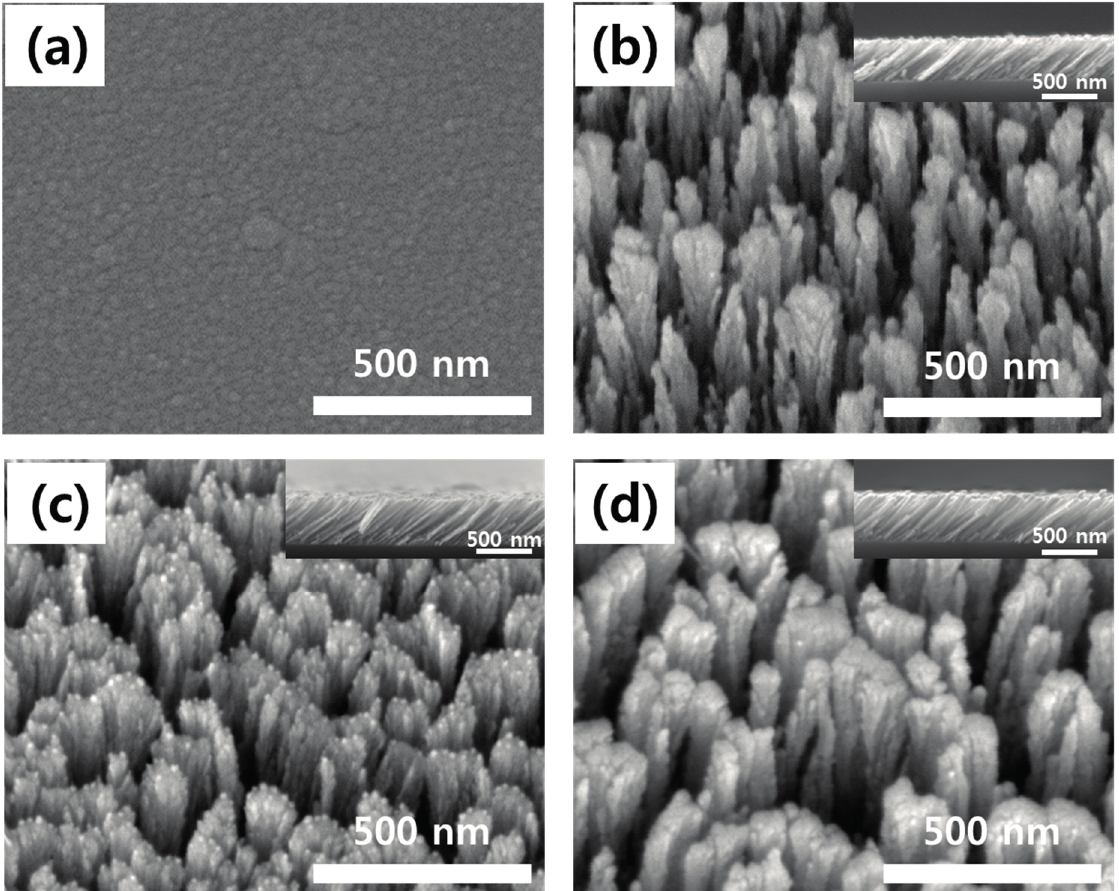
Figure 3. FESEM images. ( a ) Surface of SnO 2 thin film (glancing angle = 0°); ( b ) Surface and cross-section of SnO 2 thin film (glancing angle = 85°); ( c ) Surface and cross-section of Au-catalyzed SnO 2 thin film (glancing angle = 85°); ( d ) Surface and cross-section of Ag-catalyzed SnO 2 thin film (glancing angle =